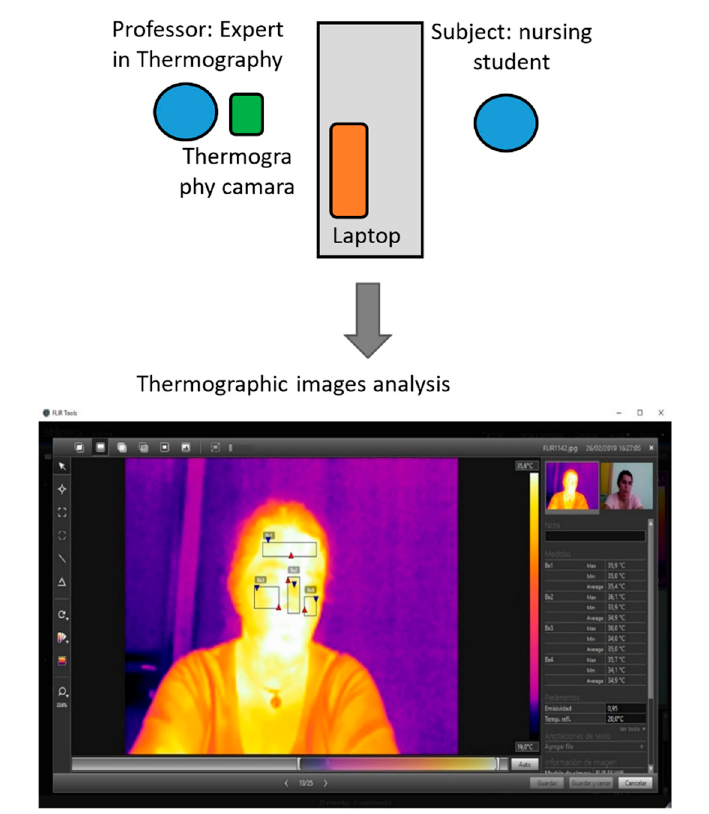
Figure 2. General methodology proposed for the study of emotions.